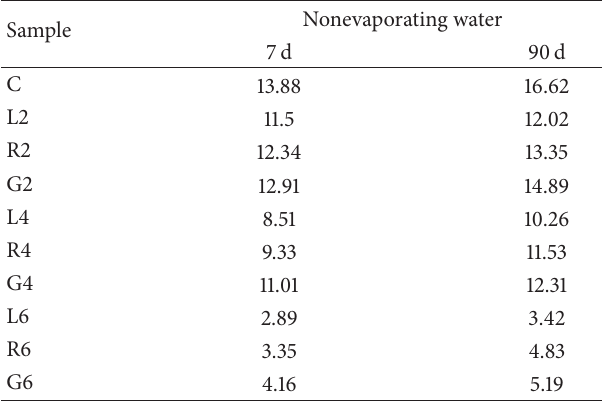
Figure 11, at 28 d, a large number of fibrous C-S-H gels grew as clusters of radiation and overlapped in group